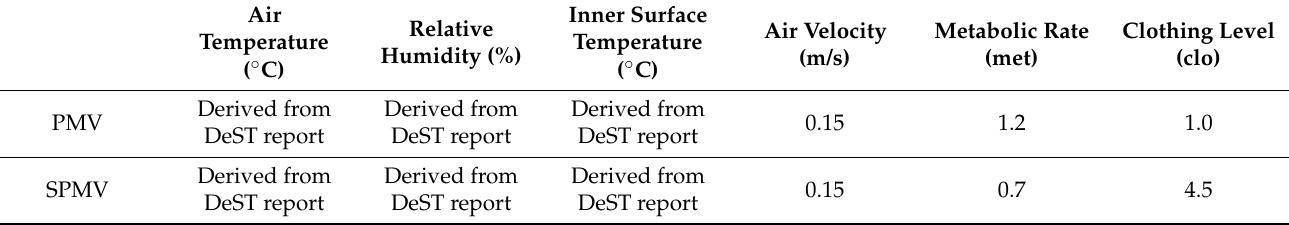
Table A5. The inputs for PMV and SPMV